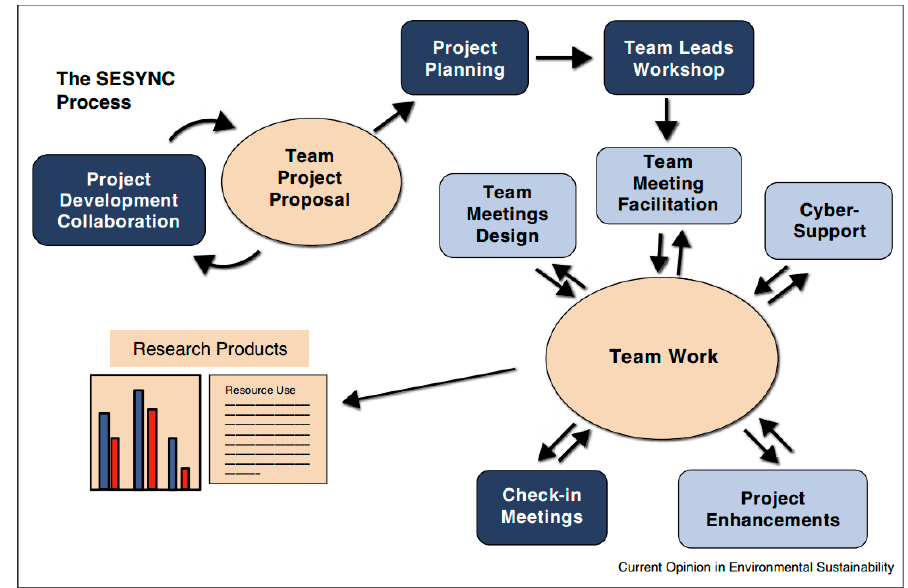
Figure 2. “The Socio-Environmental Synthesis Process”: a set of reflexive practices for fostering team progress.